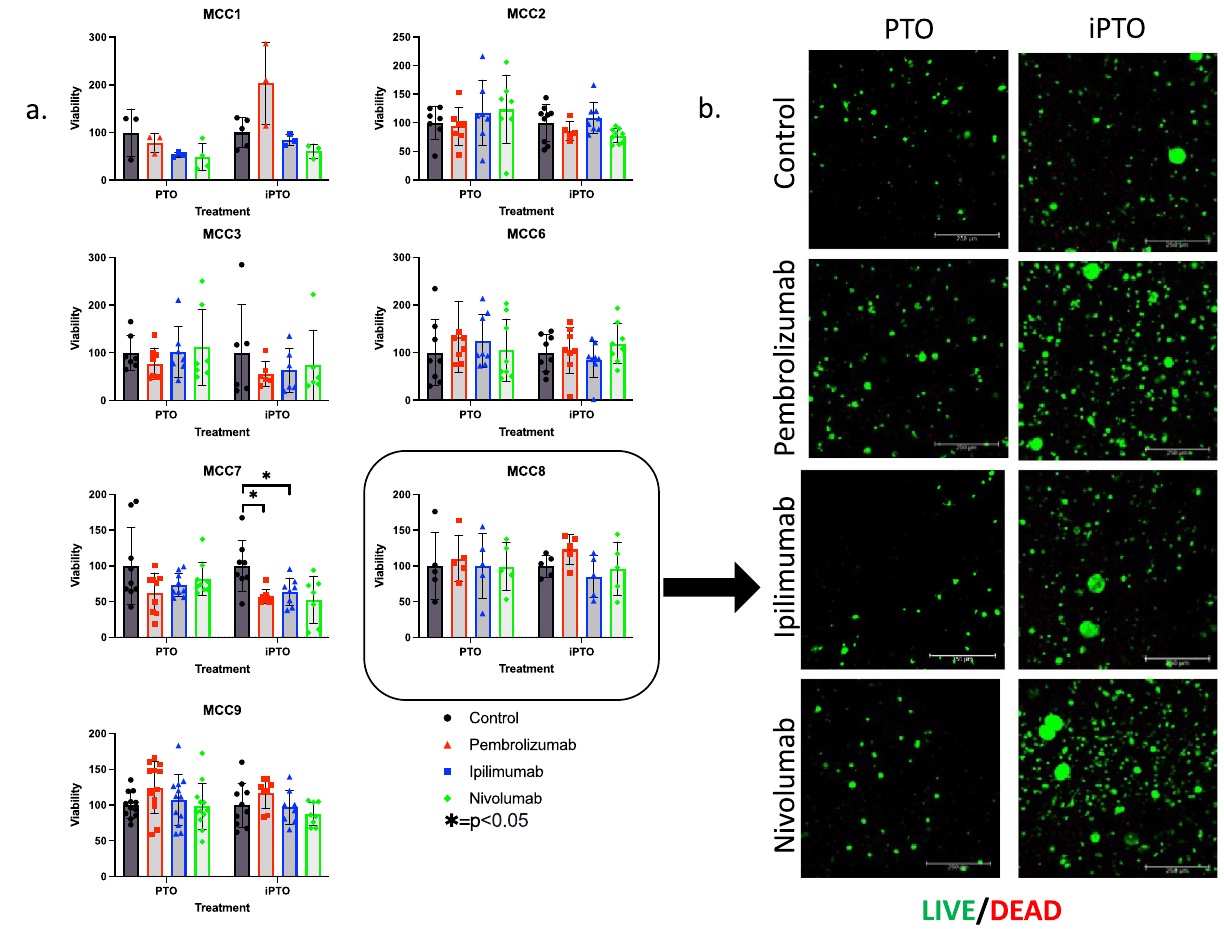
Figure 5. Demonstration of iPTOs in immunotherapy testing applications. ( a ) iPTO sets were treated with immunotherapies and viability was recorded with CellTiter-Glo 3D. No iPTOs were determined to have significant response of < 50% viability compared to control, statistical significance of p < 0.05 compared to iPTO control and to PTO counter treatment to any immunotherapies tested. ( b ) LIVE/DEAD Panel for MCC8. Scale bars represent 250 microns. *p <